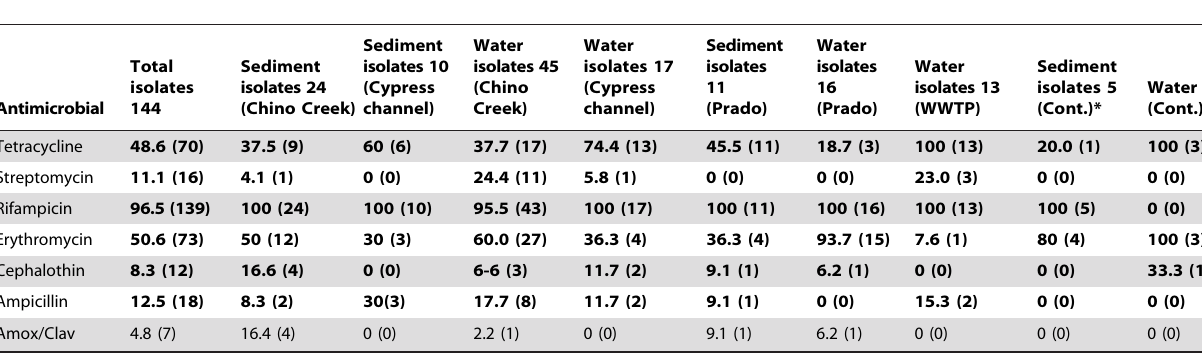
Table 4. Multiple antimicrobial resistant E. coli isolates from the major sources.